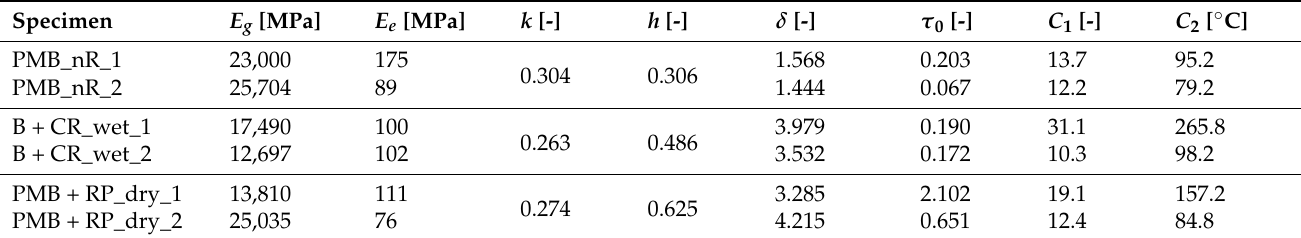
Table 5. HS and WLF model parameters (T ref = 20 ◦